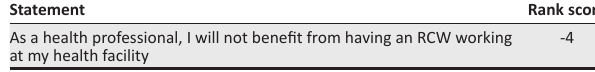
TABLE 5: The statement that participants loading onto Factor 2: ‘Promoters of participation’ strongly disagreed with. Statement